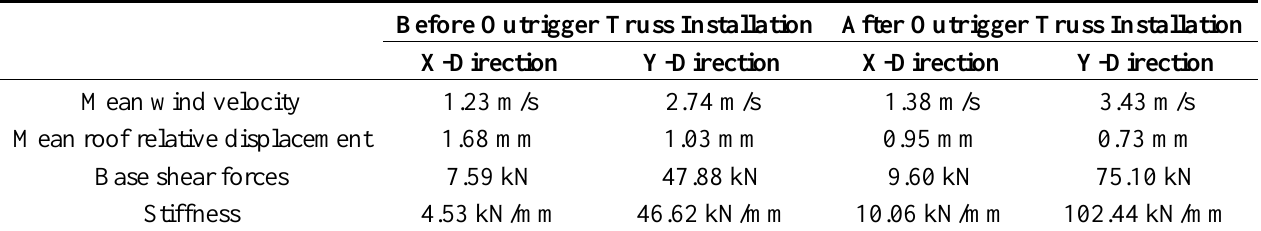
Table 3. Stiffness changes before and after outrigger truss installation.